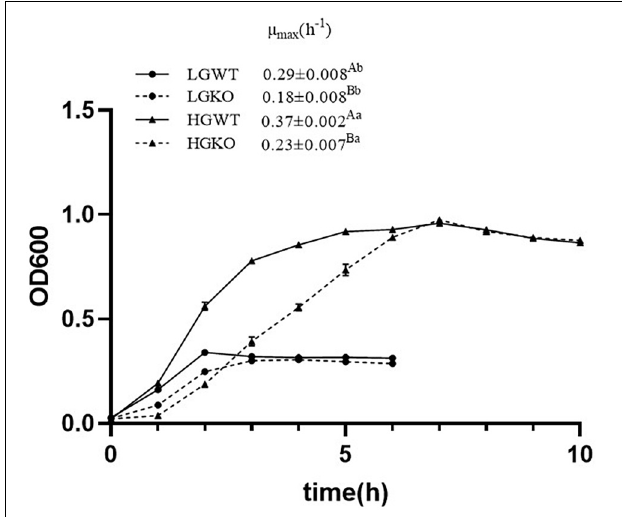
FIGURE 1 | Growth curve of wild-type strain (WT) and ccpA -knockout strain (KO) of S. bovis S1 in glucose-excess or -limited conditions measured as optical density at 600 nm (OD 600 ). Error bars indicate SD. The maximal growth rate ( µ max ) was estimated and shown in the figure. Values marked with different superscript uppercase letters (AB) indicate those are statistically significant differences ( P < 0.05) between wild-type strain (WT) and ccpA -knockout strain (KO); values marked with different superscript lowercase letters (ab) indicate those are statistically significant differences ( P < 0.05) between strains grown in glucose-excess or -limited conditions. LGWT, the wild-type strain grown in the media with 5 mM glucose; LGKO, the ccpA -knockout strain grown in the media with 5 mM glucose; HGWT, the wild-type strain grown in the media with 50 mM glucose; HGKO, the ccpA -knockout strain grown in the media with 50 mM